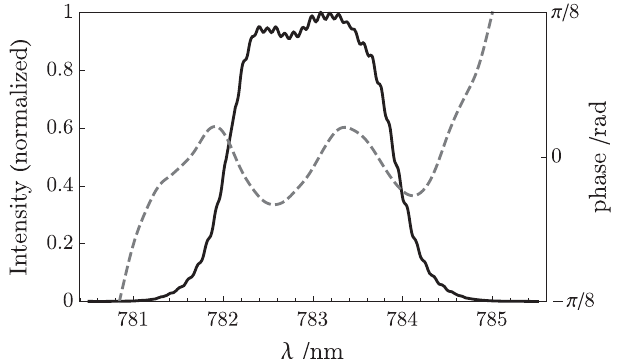
FIG. 12. Magnitude (solid line) and phase (dashed line) of the filtered pump spectral amplitude. The magnitude shown here corresponds to that measured using the OSA and agrees very well with the pump function of a low-gain JSI. The phase shown here corresponds to the addition of the phase of the unfiltered pump measured using SPIDER and the differential phase of the filtered pump measured through spectral interferometry.